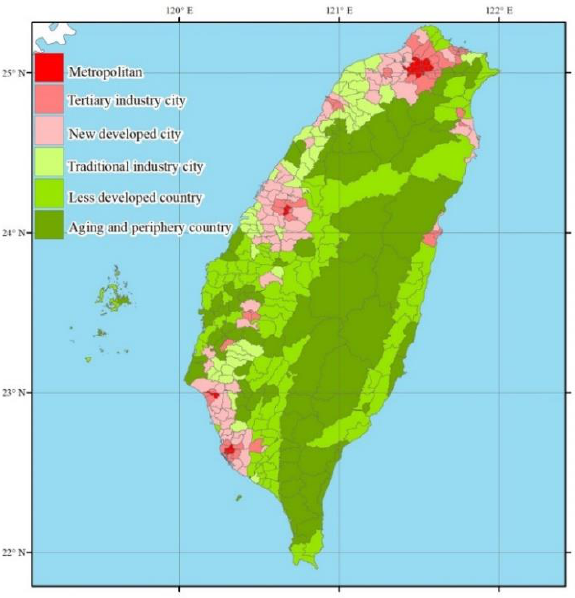
Figure 1. The Six Degrees Urbanization of our Participants.